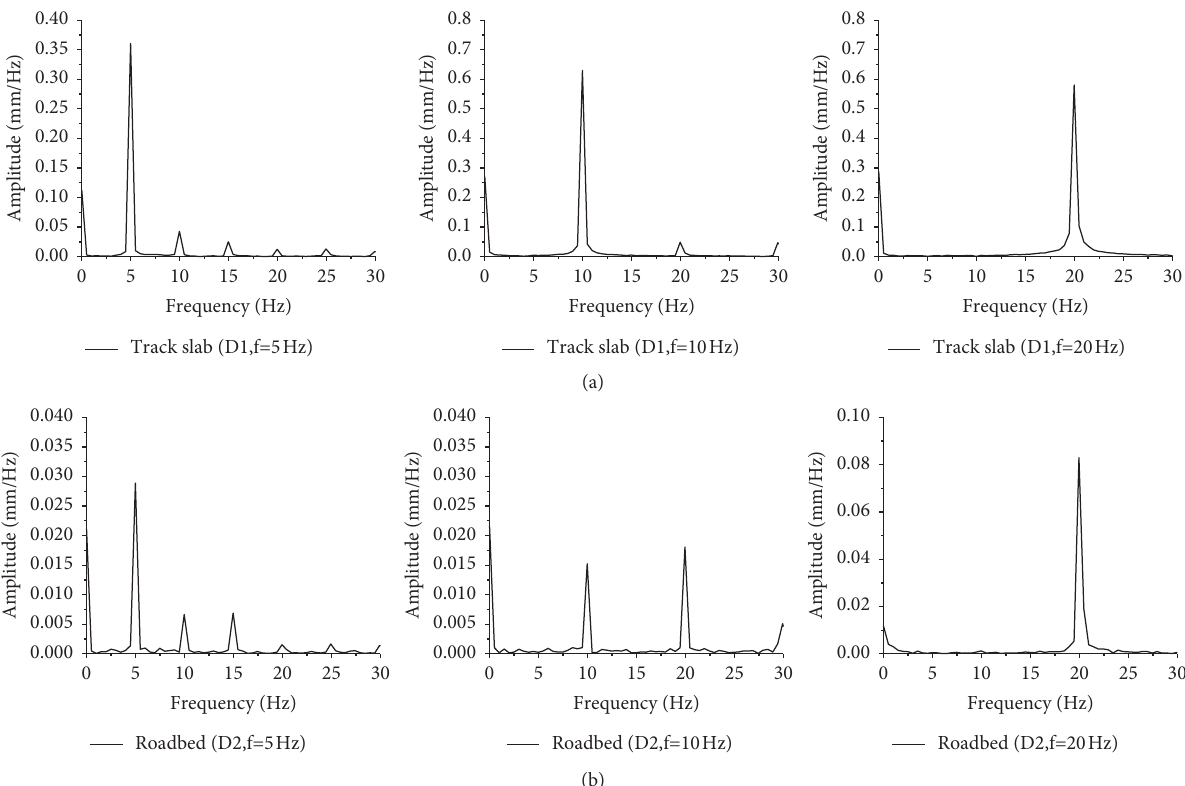
Figure 6: Frequency contents of vibration displacement at track slab (D1) and roadbed (D2). (a) Track slab (D1, f � 5Hz, 10Hz, and 20Hz). (b) Roadbed (D2, f � 5 Hz, 10Hz,